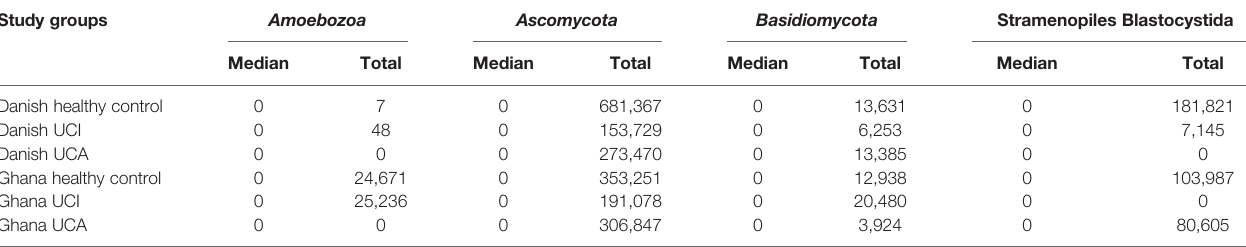
TABLE 2 | Median value for selected Eukaryota in study groups.